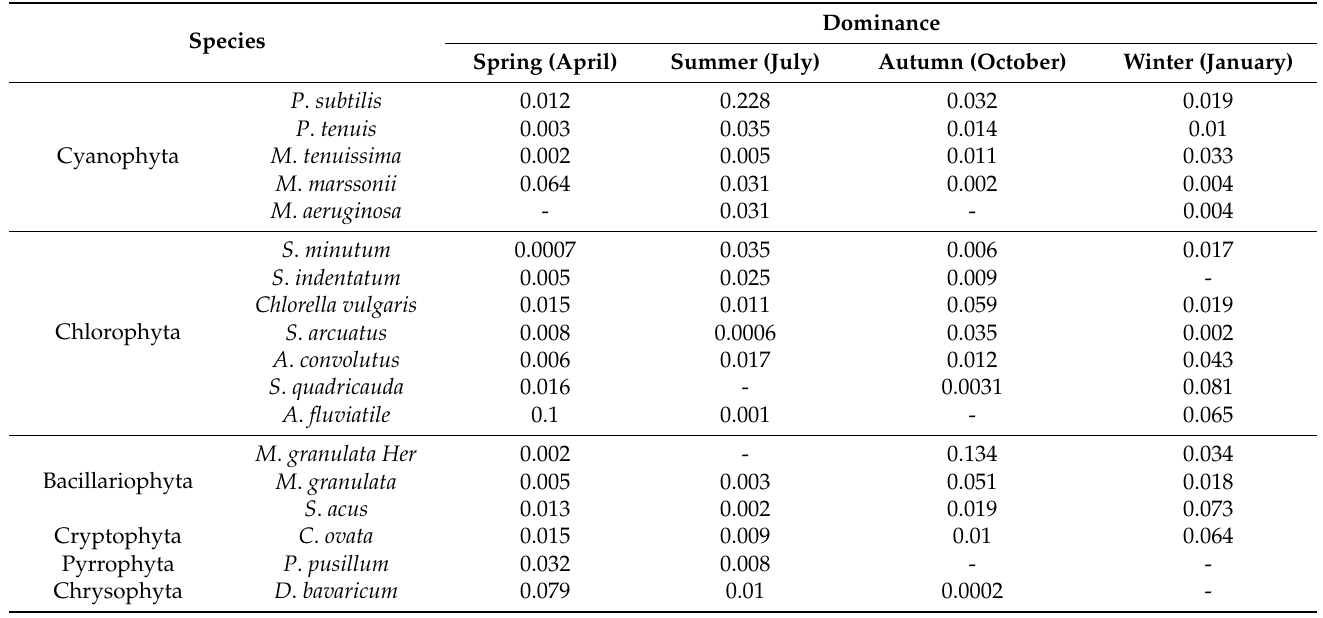
Table 2. Dominant species and dominance of phytoplankton communities in each